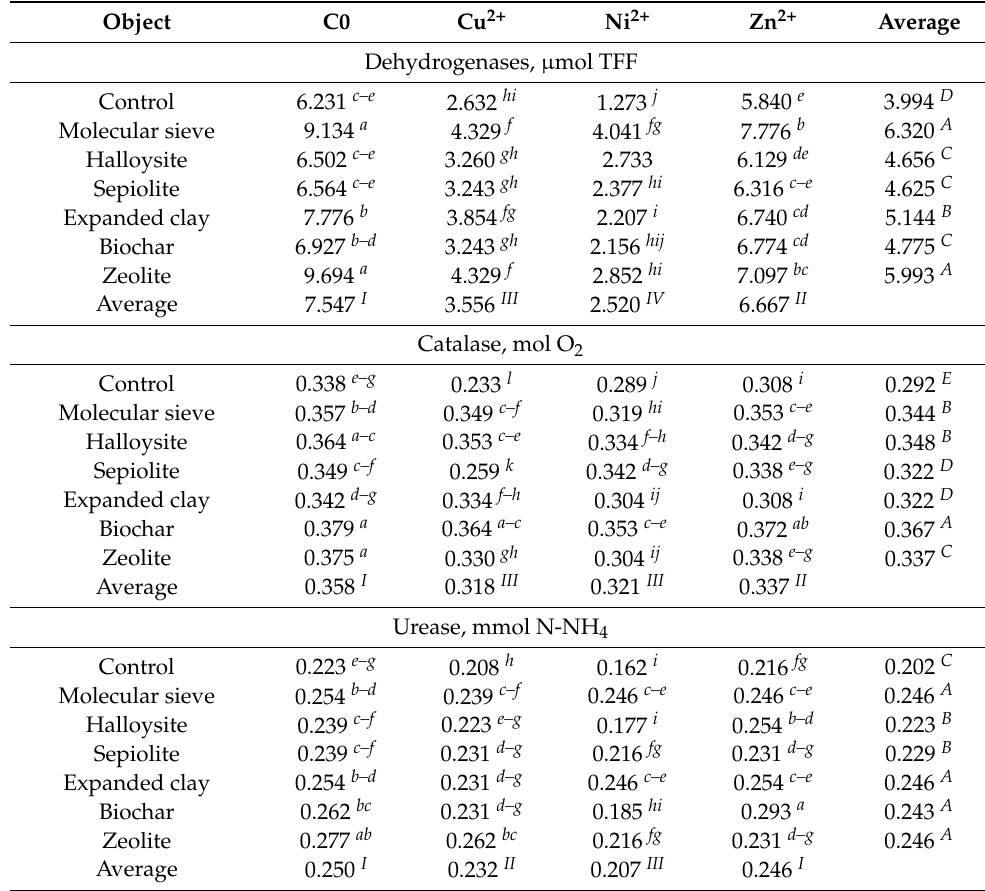
Table 3. Enzymatic activity in soil (kg − 1 d.m. of soil · h − 1 ).